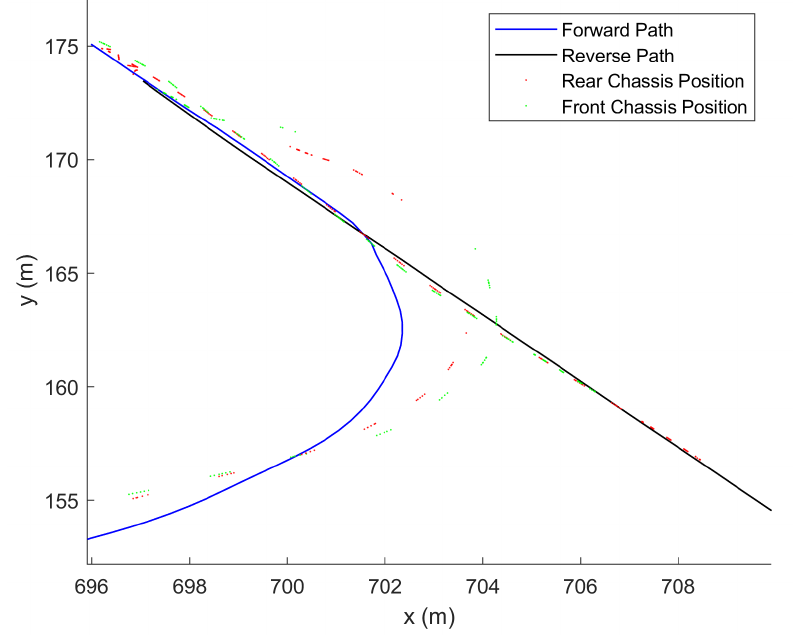
Figure 15. Docking maneuver in A3. This maneuver includes both forward and reverse path tracking, the order of operations is decided by the FSM. Blue line represents the path constructed from the waypoints. The red markers represent the GPS position of the front chassis read from the simulator. Similarly, the green markers represent the rear chassis.